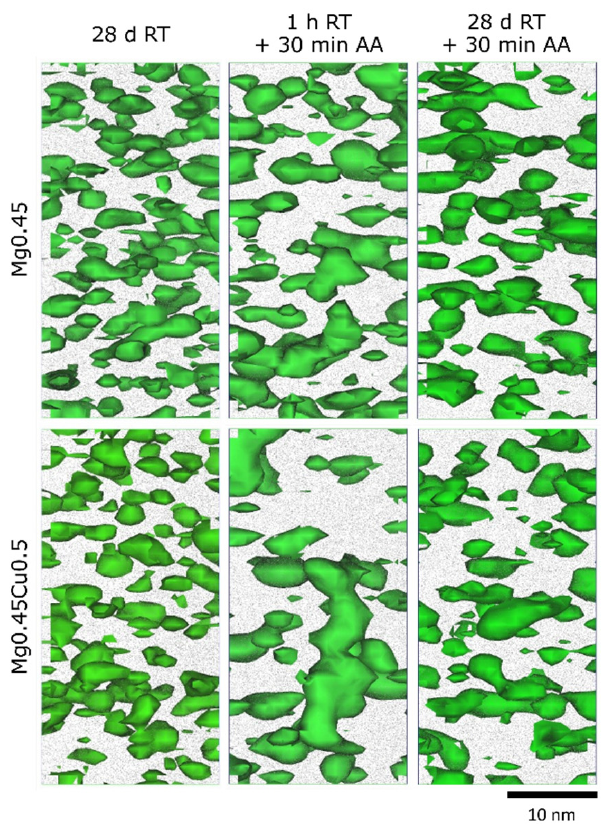
Figure 4. APT subvolumes (20 × 20 × 40 nm 3 ) of alloys Mg0.45(Cu0.5) with 28-day RT storage and/or 30 min aging at 175 °C. The 1.5% Mg concentration isosurfaces are shown ( green ) with Al atoms ( gray ). Table 2. Measured bulk composition and composition of Al grains by APT and other techniques (at.%). A discussion of error sources in APT is available in the Supplementary Material